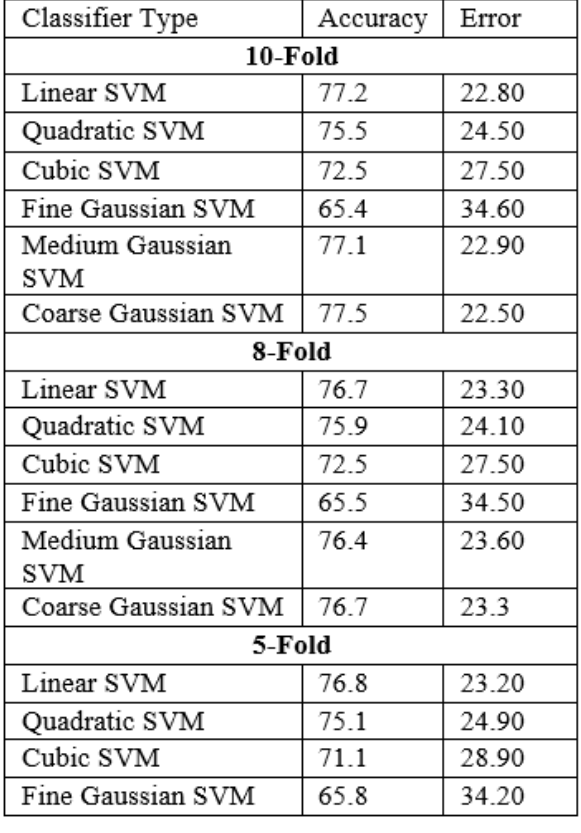
Table 8. Configuration &complexity in